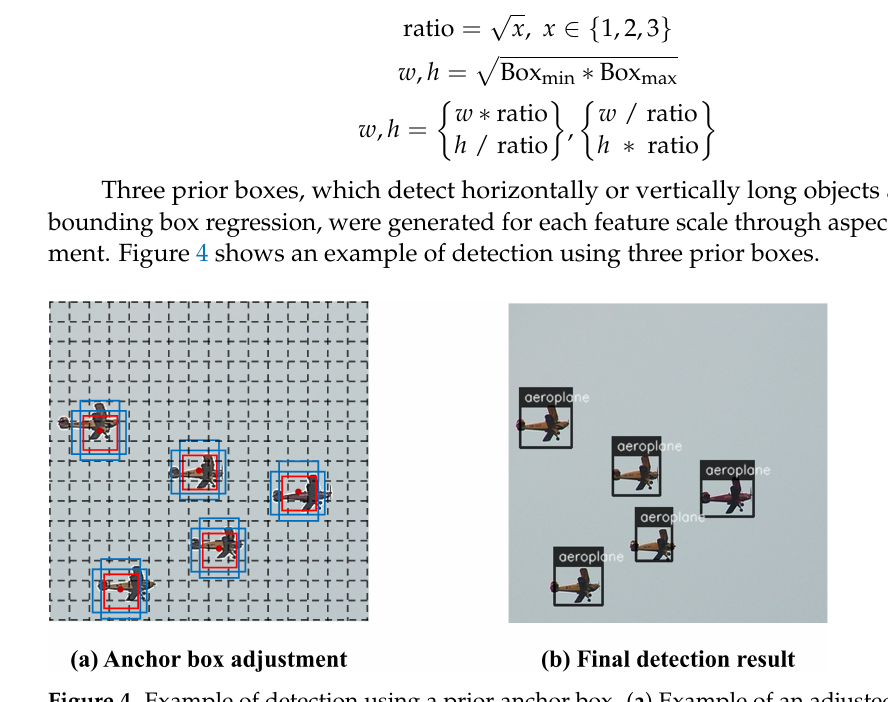
Figure 4. Example of detection using a prior anchor box. ( a ) Example of an adjusted prior anchor box. ( b ) Detection results using the adjusted anchor box. Three prior boxes are used for each head, and the positive sample most consistent with groundtruth is